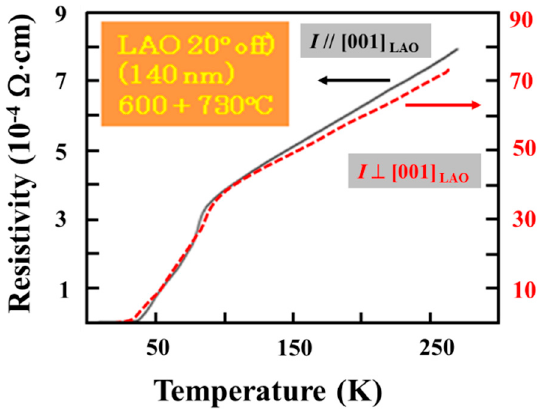
Figure 9. Resistivity vs. temperature measured on the film from Figure 8b when measuring current I is applied parallel (full line) and perpendicular (dashed line) to the [001] direction of the